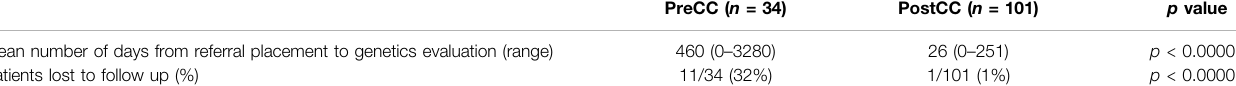
TABLE 2 | Outcomes of referral placement.